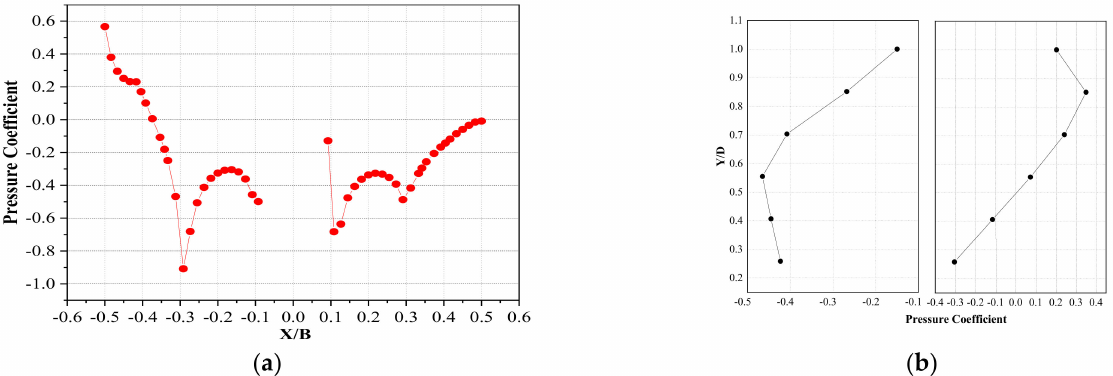
Figure 15. Pressure distribution of pressure measuring Section 1 in numerical simulation of vortex- induced vibration. ( a ) Pressure distribution on the lower surface of pressure measuring Section 1 of the main beam; ( b ) Pressure distribution of the upstream and downstream sections of the middle